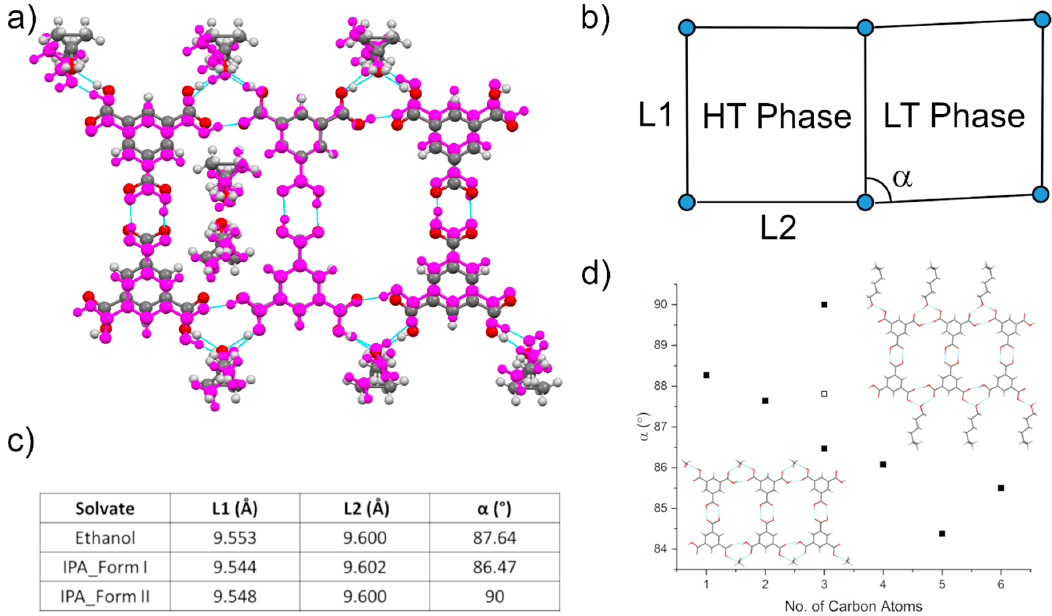
Figure 4. ( a ) An overlay of the low-temperature (purple) and high-temperature (elemental colour) polymorphs of the TMA:IPA solvate indicating the increase in the disorder of solvent. The solvent molecules from layers above and below are shown in the ring; ( b ) the relationship between the centroids of the TMA molecules in the two phases where R 44 (32) rings become more skewed. The extent of the skew is defined using the lengths between centroids (L1 and L2) and the angle between them ( α ); ( c ) the parameters for the ethanol and two IPA polymorphs; ( d ) the distortion of the TMA framework as a function of carbon length in the alcohols. Greater skew of the TMA framework is observed for longer chain length. The n = 3 points are for isopropanol (filled squares) and propanol (unfilled squares). Pentanol shows greater distortion due to the new packing arrangement of the solvent in the pockets. References are: methanol [9], propanol (LT form) [8], butanol-hexanol [7].